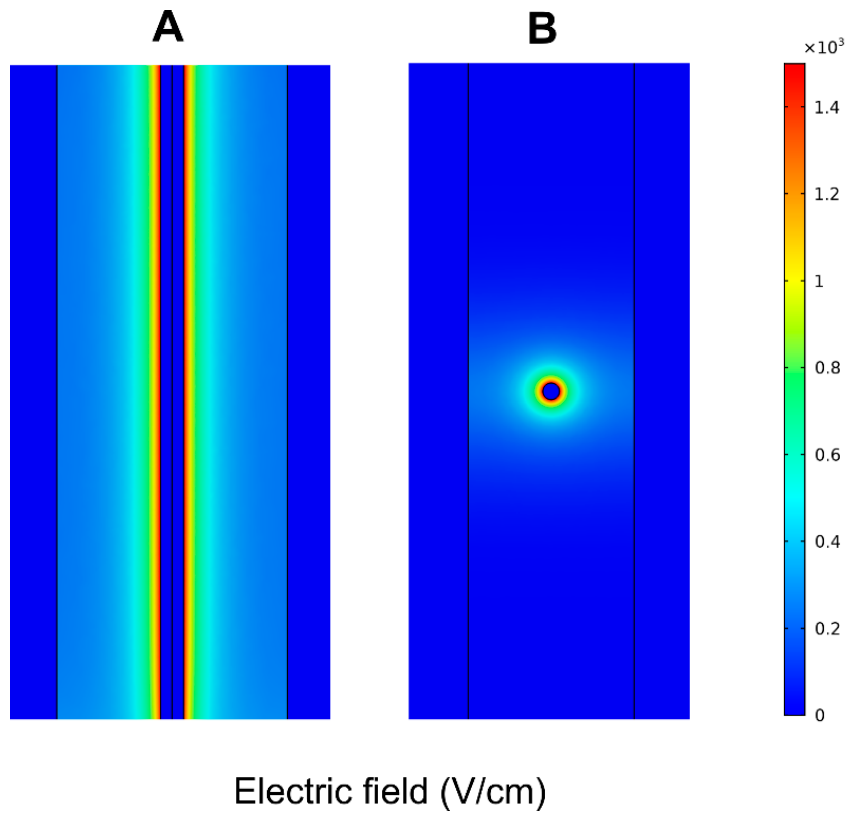
Figure 3. Spatial distribution of electric field inside the electroporation cuvette with the center needle electrode, where ( A ) side-view; ( B ) top-view.